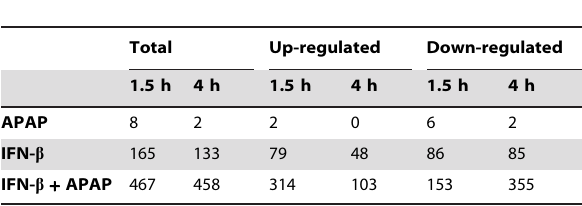
Table 1. Probes that detected significantly (FDR # 0.05) changed transcript levels and had a 1.5-fold difference from the vehicle